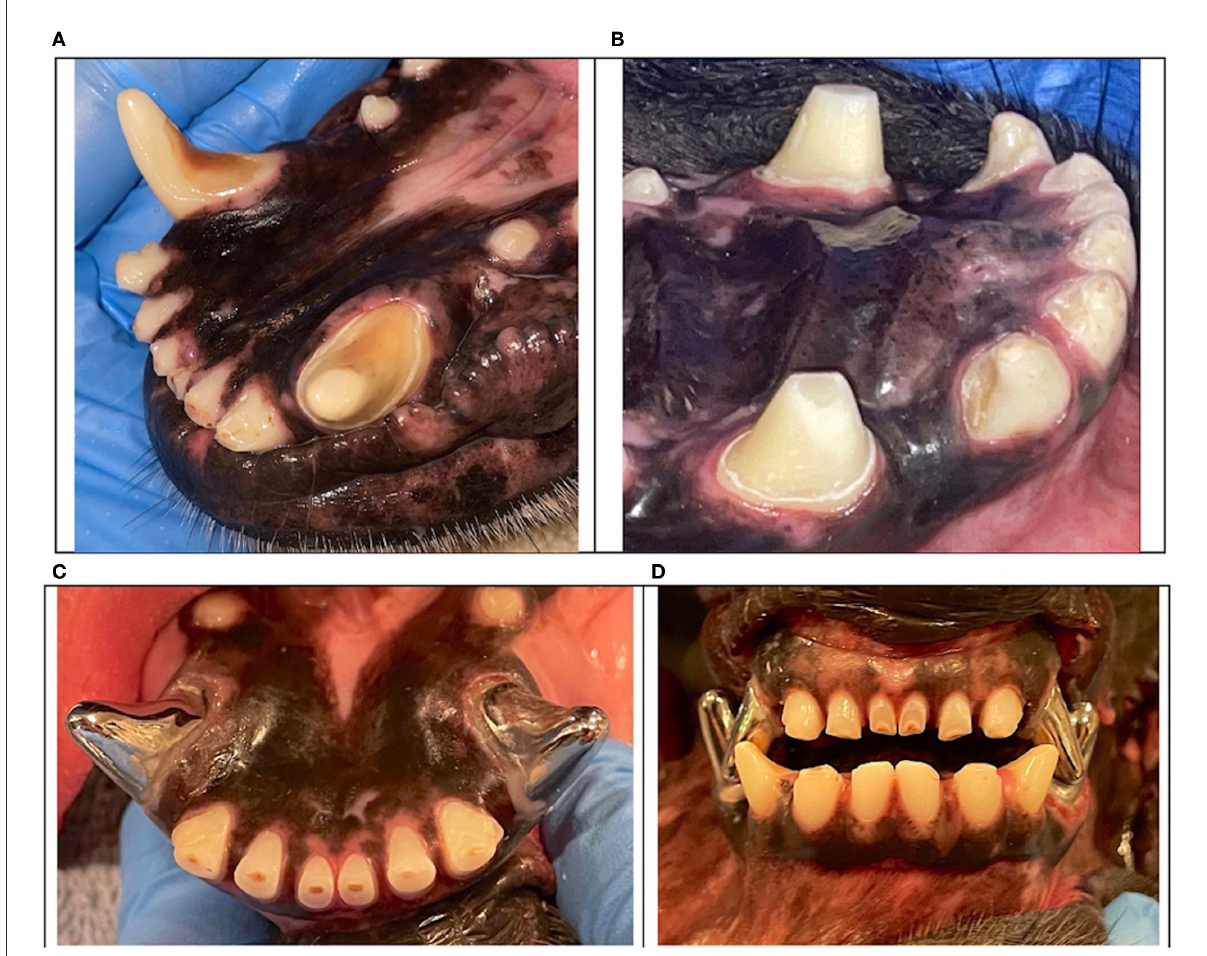
FIGURE13 Clinical photographs demonstrating significant trauma to the distal surface of the lower mandibular canines (A) with crown shortening, endodontic therapy, and prosthodontic crown preparation (B) . Crown delivery of the lower mandibular canines (C) and crown delivery of both the maxillary and mandibular canines in a young MWD to preserve a functional occlusion (D)